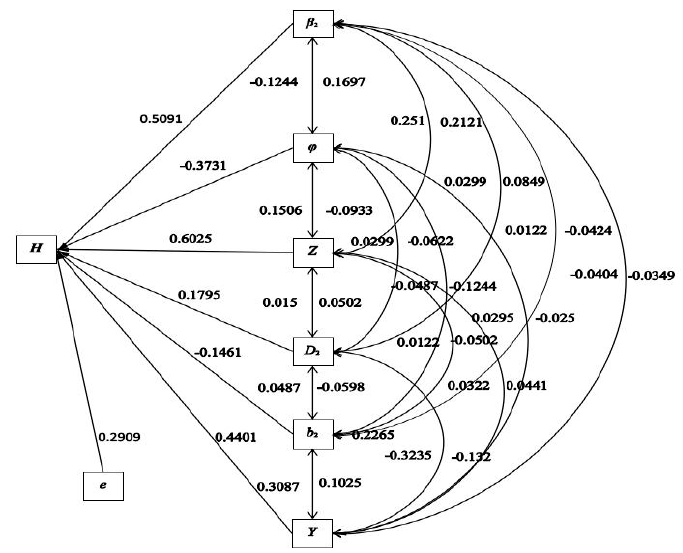
( b ) The path diagram between the impeller geometrical parameters and the head Figure 3. The path diagram between the impeller geometrical parameters and the performance.